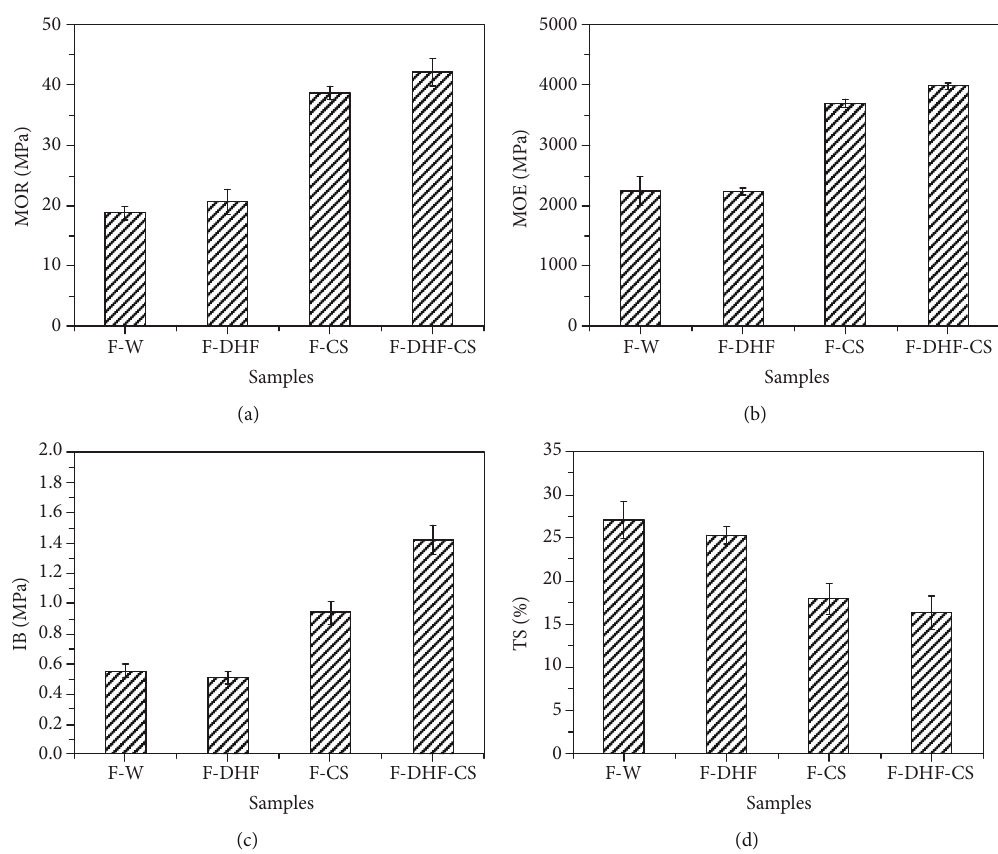
Figure 5: Physical and mechanical properties of F-W, F-DHF, F-CS, and F-DHF-CS: (a) MOR; (b) MOE; (c) IB; (d)